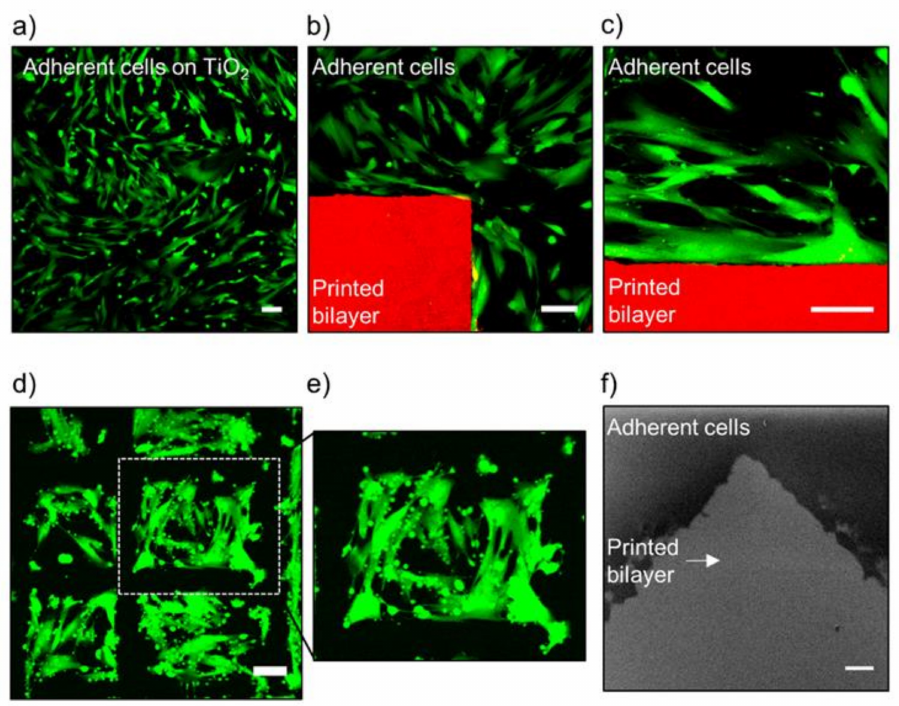
Figure 5. Adhesion of human fibroblast cells to a bare TiO 2 surface with confinement by printed phospholipid bilayers: ( a ) Confocal image of adhered cells (green) on a bare TiO 2 surface. ( b ) Con- focal images of adhered cells (green) on a bare TiO 2 surface with confinement by inkjet-printed phospholipid bilayers (red), and ( c ) its magnification. ( d ) Confinement of cell cultures (green) by printed lipid bilayers (not labeled, black), and ( e ) magnified view. ( f ) SEM characterization of the interface between a printed bilayer and cells. Confocal image scale bar: 100 µ m, SEM image scale bar: 50 µ